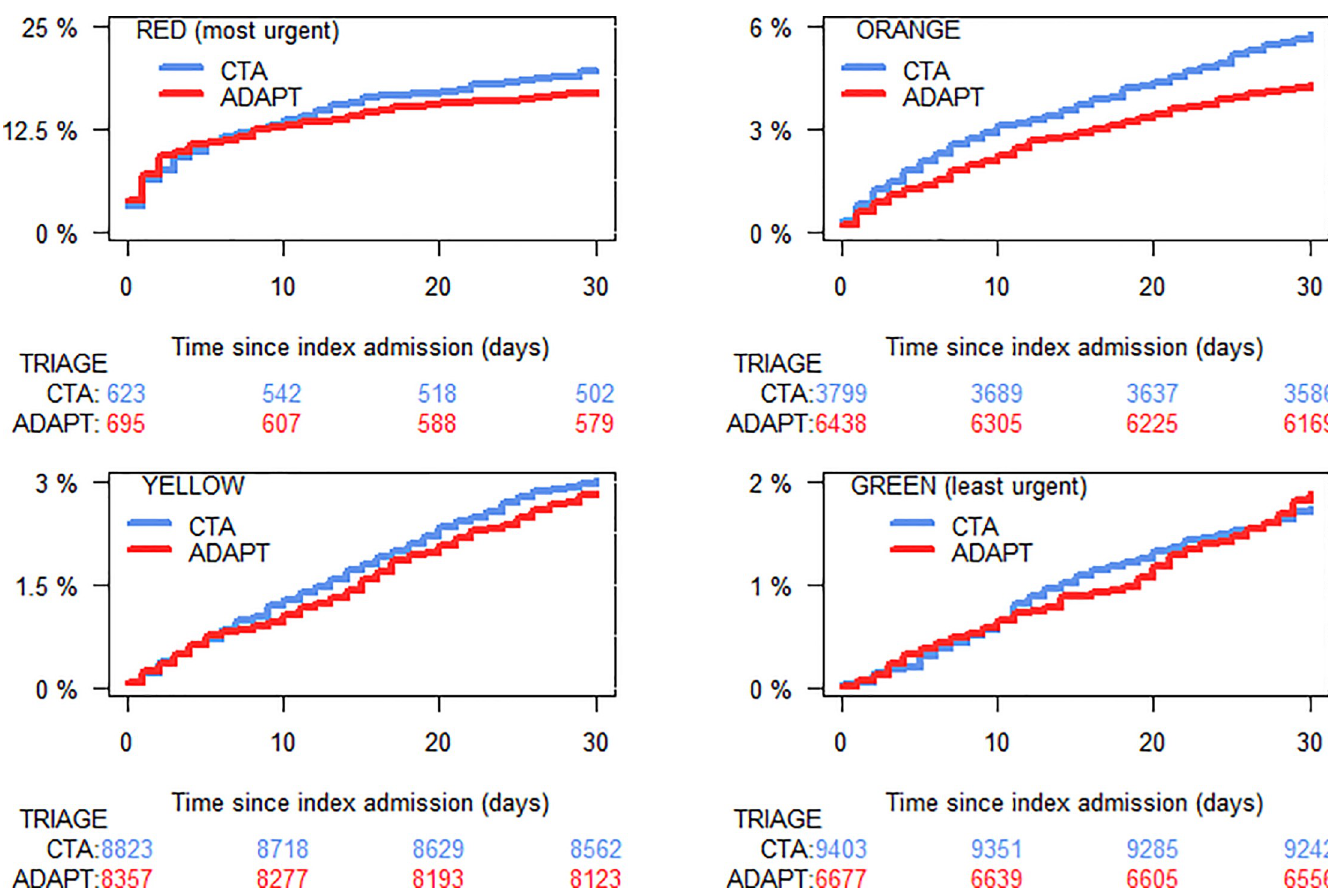
Fig 3. Cumulative incidence. 30-day all-cause mortality and distribution of triage levels for patients admitted to the emergency department.